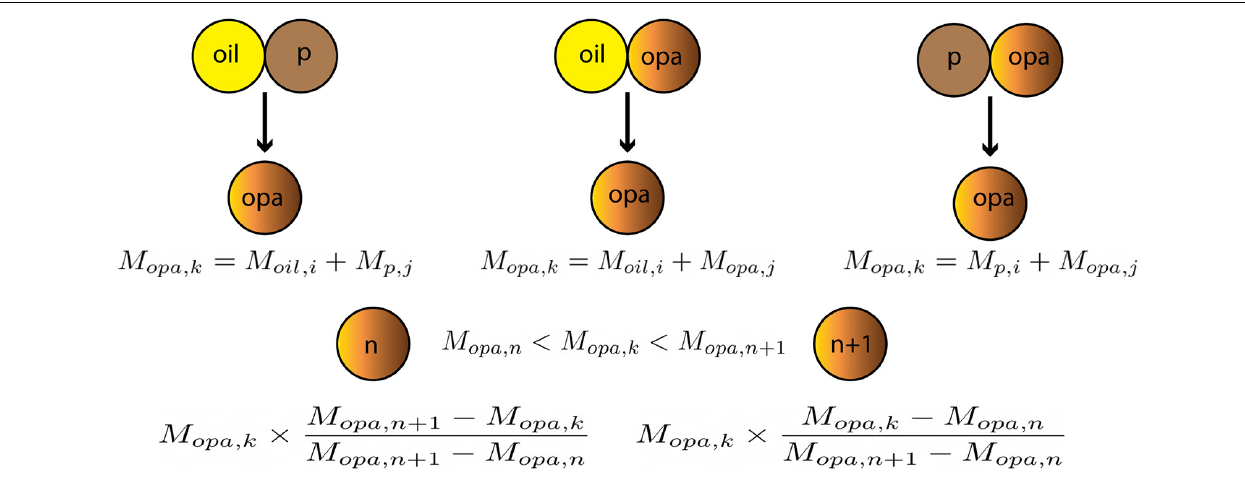
FIGURE 1 | Schematic of modeled formation processes for OPA. M opa , k is the mass of newly formed OPA of class k , which is the mass addition of two collision components (e.g., collision between the ith – class oil M oil , i and the jth – class sediment M p , j ). Assuming that M opa , k falls between two OPA classes, then this mass is mass-linearly distributed into the two neighboring classes [i.e. the nth and (n+1)th OPA